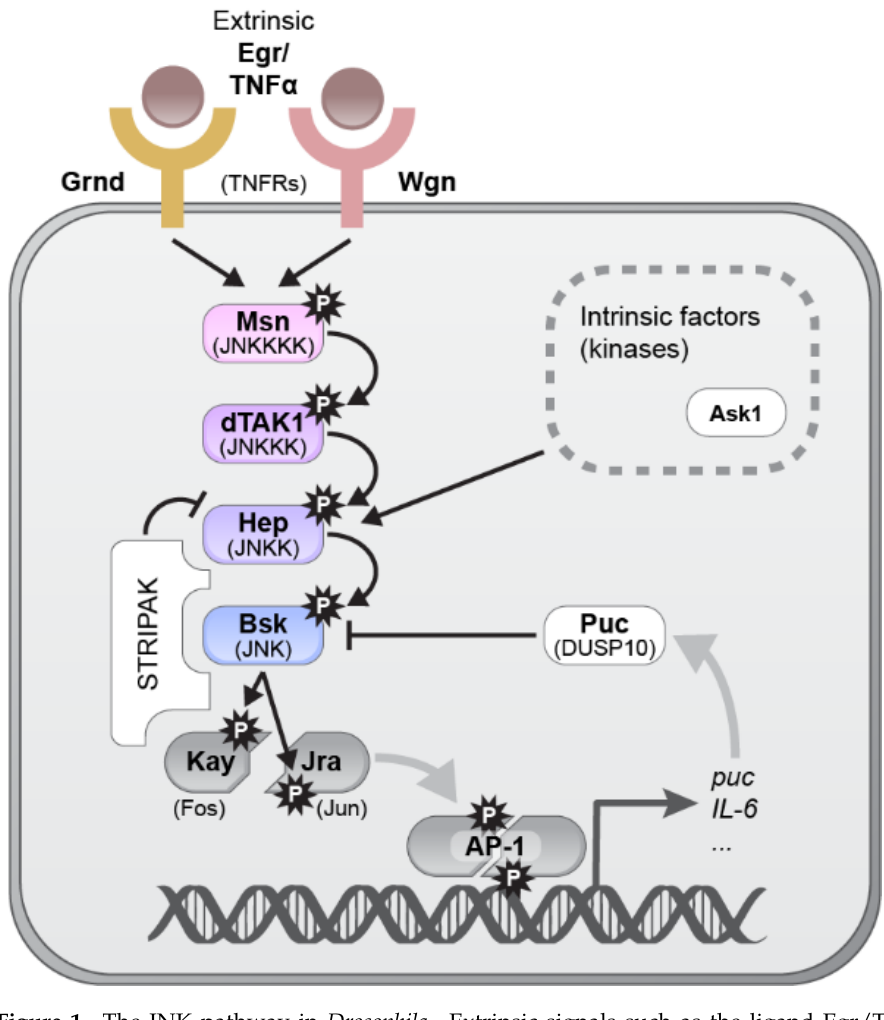
Figure 1. The JNK pathway in Drosophila . Extrinsic signals such as the ligand Egr /TNFα can bind the TNFα receptors (TNFRs) Grnd and Wgn, activating a cascade of kinases: Msn/JNKKKK, dTAK1/JNKKK, Hep/JNKK and Bsk/JNK. Hep/JNKK can also be phosphorylated by intrinsic factors (outlined by the dashed line), such as Ask1. Bsk/JNK phosphorylates the AP-1 transcription factor components Kay/Fos and Jra/Jun. AP-1 target genes include puc/DUSP10 , which encodes a phosphatase that inactivates Bsk/JNK in a negative feedback loop, and upd/IL-6 , encoding an inflammatory cytokine. The STRIPAK complex that binds to Hep/JNKK, Bsk/JNK and AP-1 and inhibits the pathway.